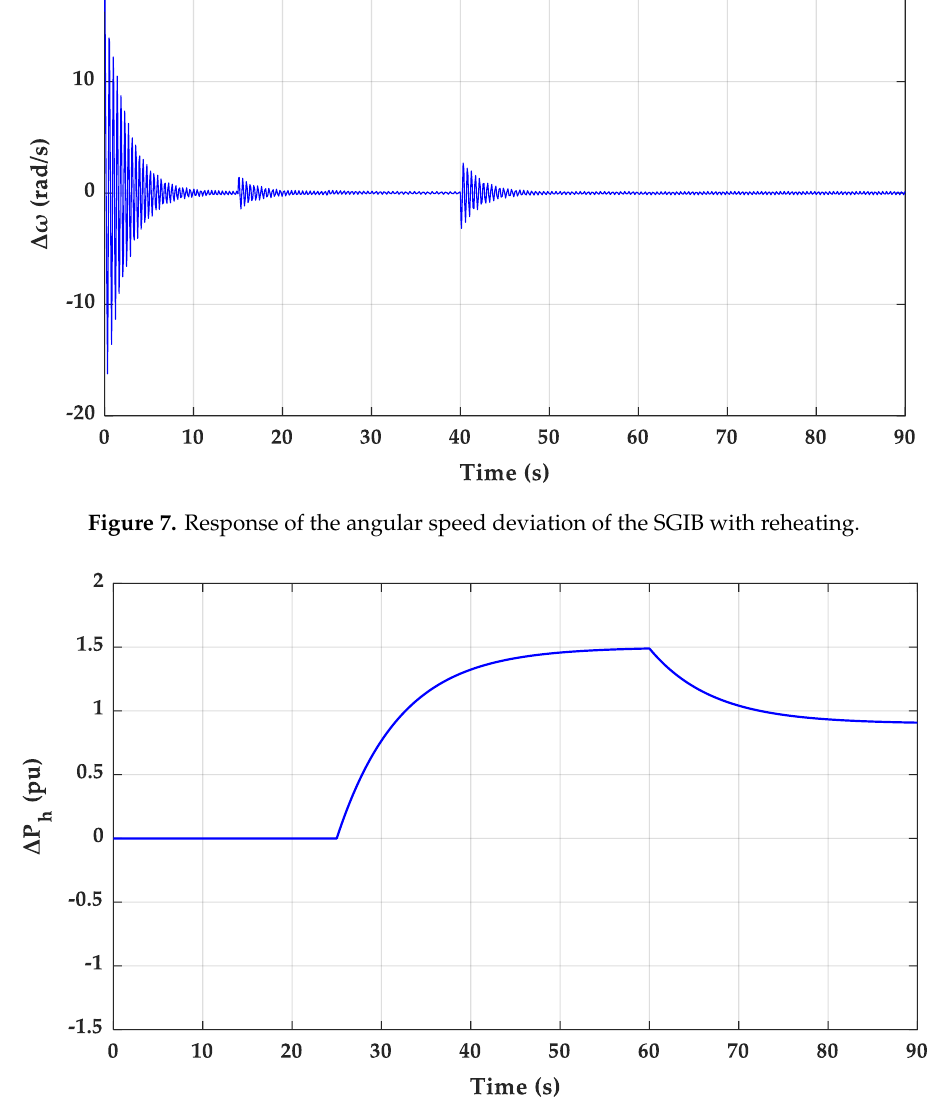
Figure 8. Response of the high-pressure part power deviation of the SGIB with reheating.